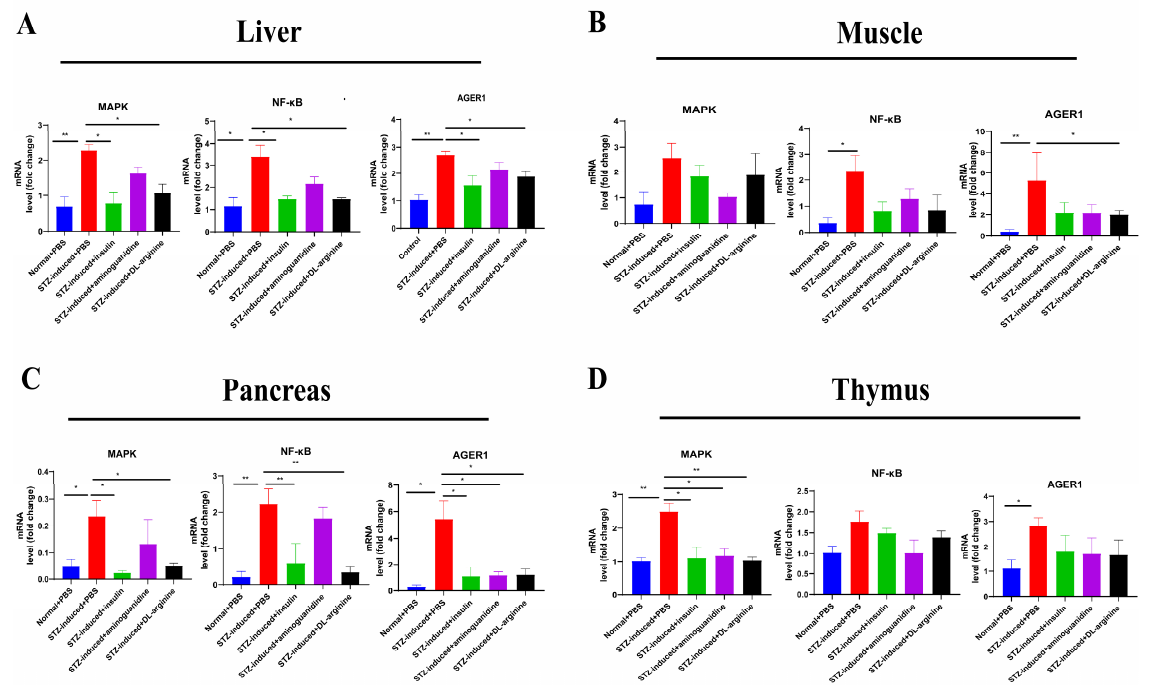
Figure 12. Effects of DL-arginine on the expression of inflammatory genes (MAPK, NF-κB, AGER1) in rat tissues. ( A ) Expression of mitogen-activated protein kinase ( MAPK ), nuclear factor- κB ( NF- κB ), and AGE receptor 1 ( AGER1 ) mRNA in the liver was analyzed by quantitative RT-PCR. ( B ) Expression of MAPK, NF-κB, and AGER1 mRNA in muscle was analyzed by quantitative RT-PCR. ( C ) Expression of MAPK, NF-κB, and AGER1 mRNA in the pancreas was analyzed by quantitative RT-PCR. ( D ) Expression of MAPK, NF-κB , and AGER1 mRNA in the thymus was analyzed by quantitative RT-PCR. All values of ( A – D ) are means ± SE; n = 3 per group, with * p < 0.05, ** p < 0.01, determined by one-way ANOVA.